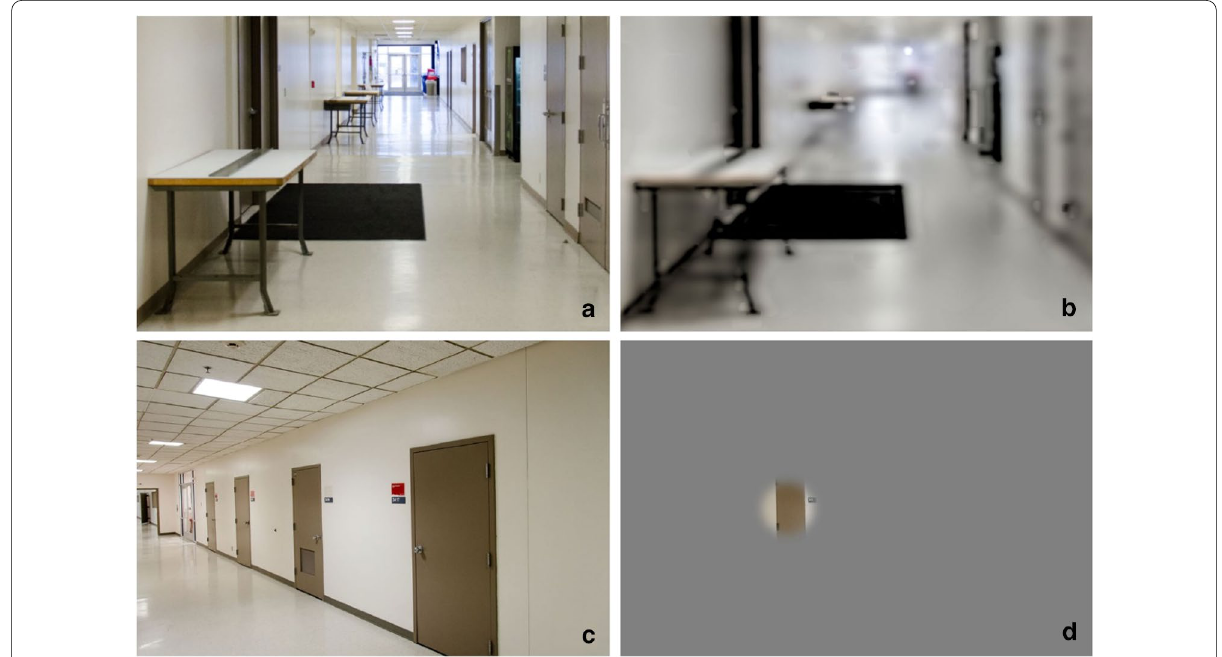
Fig. 1 Hallway scenes with normal vision and simulated low vision show possible effects on visibility and use of environmental features for spatial behavior. Photographs by William B.